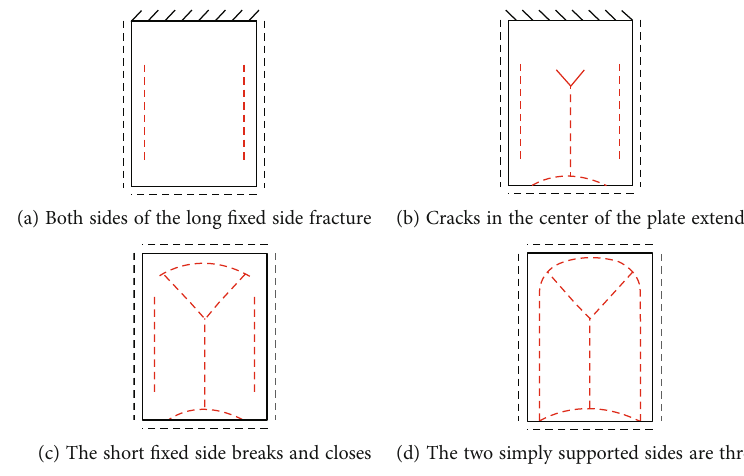
Figure 12: Fracture evolution process of mutative mining stope